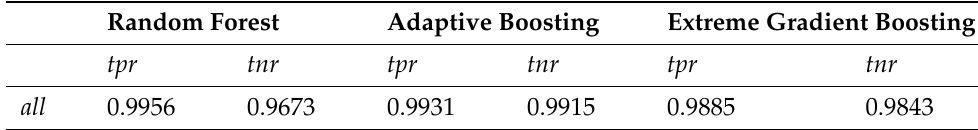
Table 21. Extended BankSim dataset ensemble methods based fraud